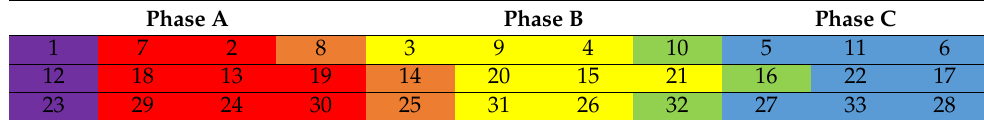
Table 10. Slot distribution to phases of M 2 .